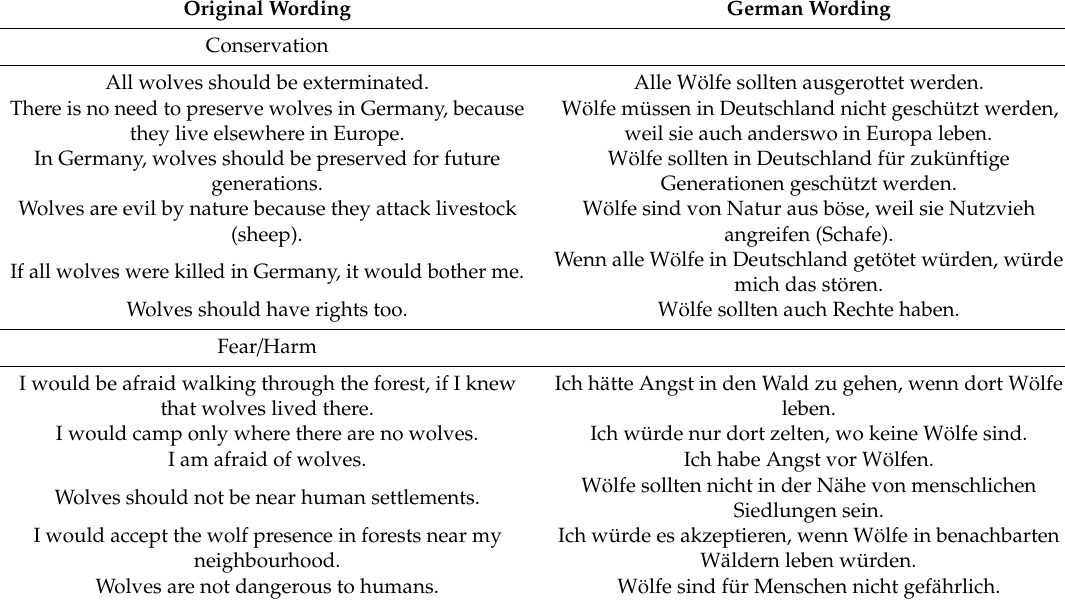
Figure A1. Wolf area in Baden-Württemberg (depicted in dark grey; Ministerium für Umwelt, Klima und Energiewirtschaft Baden-Württemberg, 2018 [39]). Table A1. Measurement for attitudes toward wolves.